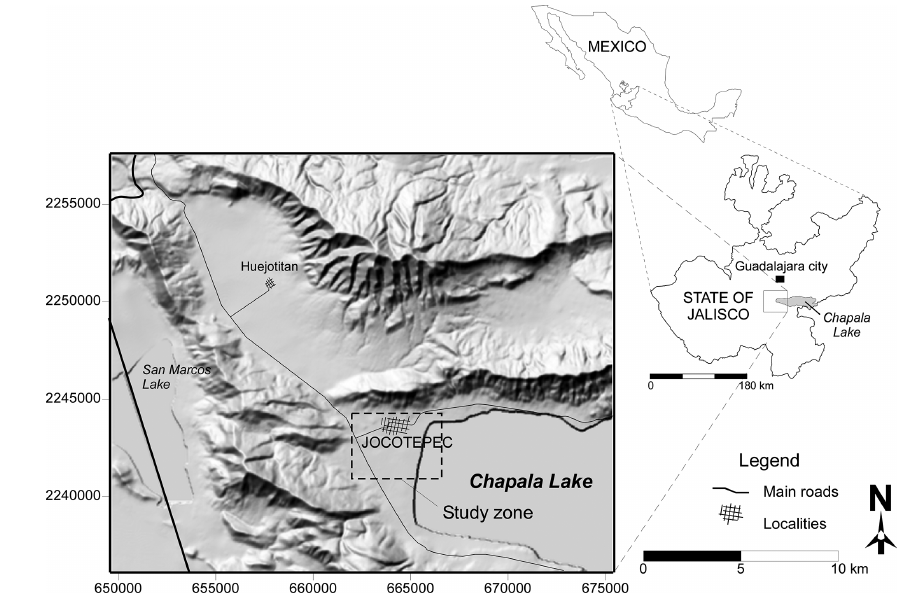
Figure 1. Location of the study area in the west part of the Chapala lake. From Hernandez-Marin et al.